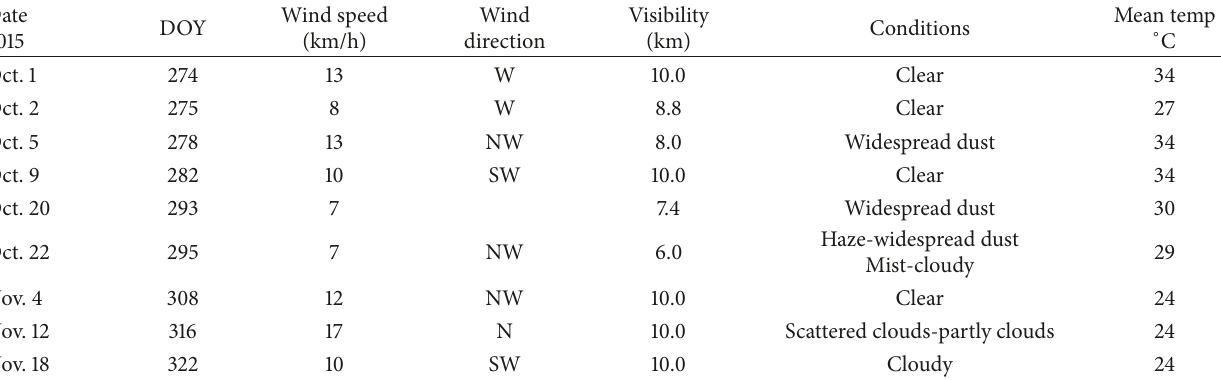
Table2:WeatherconditionsonselecteddaysduringOct.andNov.2015(KingAbdulazizAirBaseStation)(source:https://www.wunderground .com/).